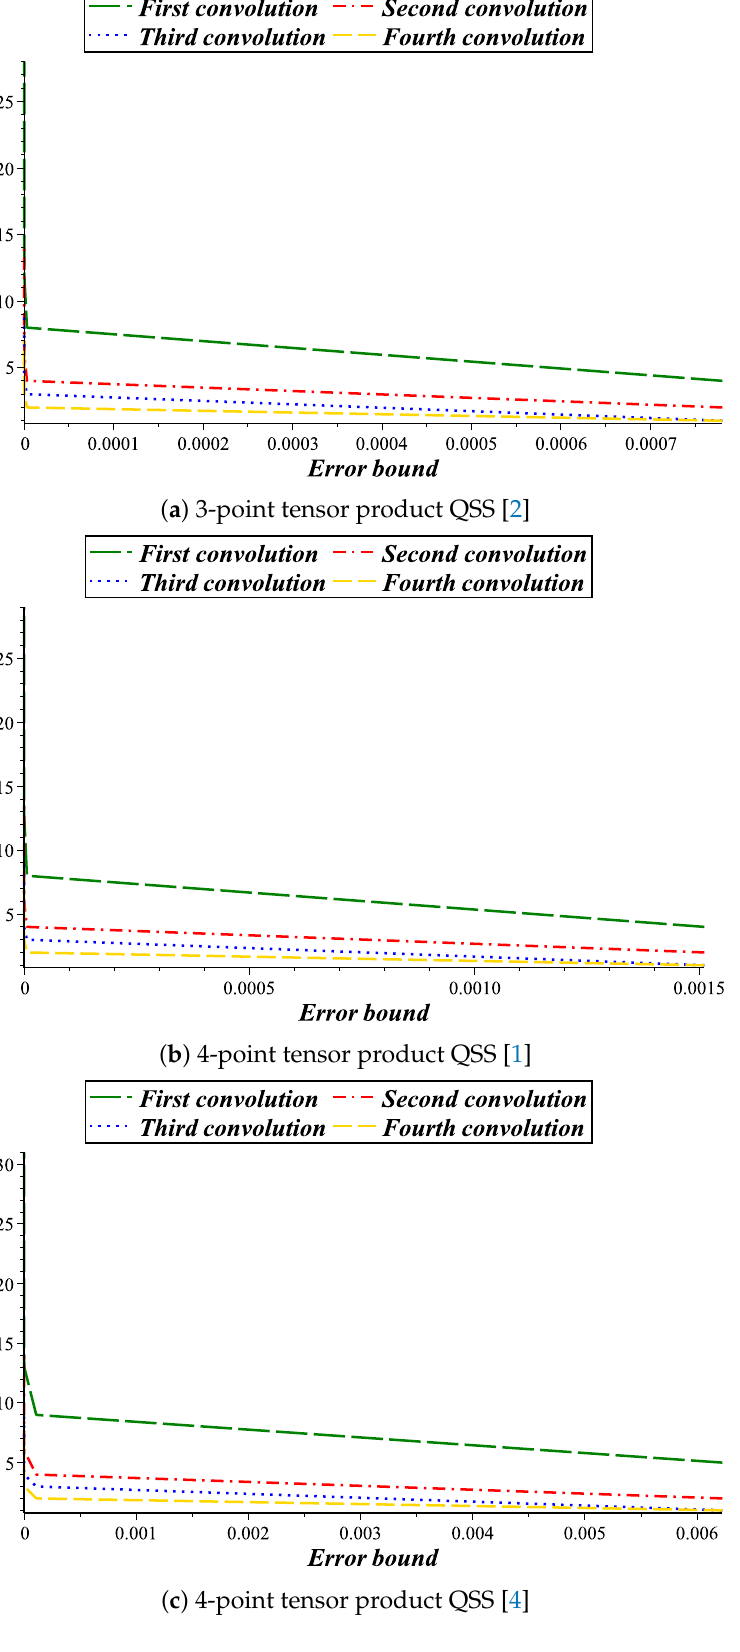
Figure 4. The comparison between different convolutions for the surface